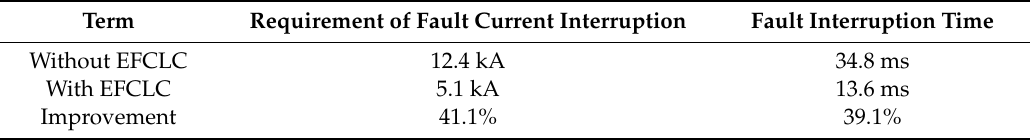
Table 4. E ff ectiveness verification of enhance fault current limiting